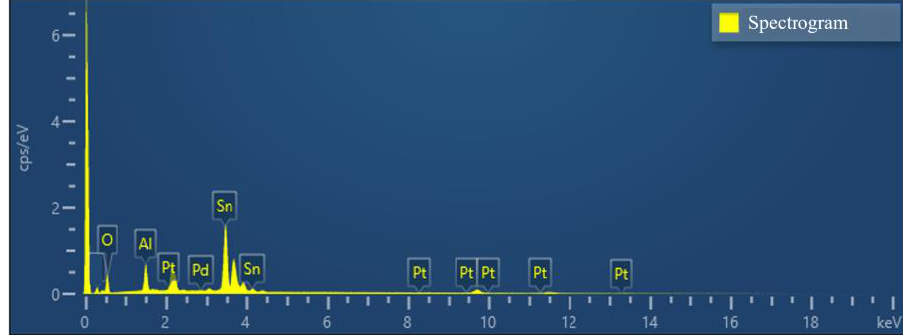
Figure 3. Elemental distribution of Pd – Pt/SnO 2 /Al 2 O 3 films: ( a ) elegional elemental distribution maps; and ( b ) single elemental distribution maps.